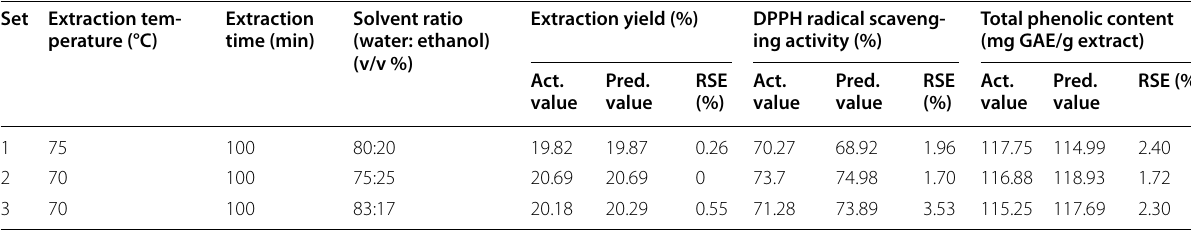
Table 5 Predicted and actual response values for the verification model Set Extraction tem- perature (°C)